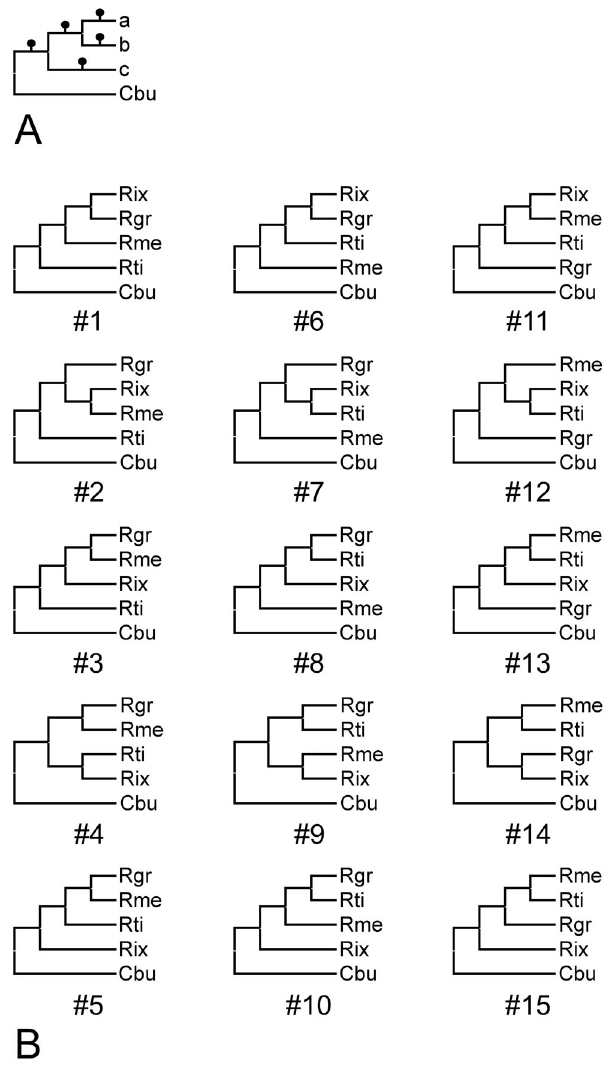
Figure 4. Generation of candidate tree topologies for likeli- hood-based significance testing based on MLST markers. 15 candidate topologies were generated from a four organism basic tree ( A ) comprising Coxiella burnetii (acronym ‘‘Cbu’’) as outgroup together with three Rickettsiella strains in positions a–c. The candidate topologies tested ( B ) were generated from this basic tree by the following steps: 1. Permutative addition of three Rickettsiella strains representing the species Rickettsiella grylli (‘‘Rgr’’) and the pathotypes ‘ Rickettsiella melolonthae ’ (‘‘Rme’’) and ‘ Rickettsiella tipulae ’ (‘‘Rti’’) to positions a–c generates a maximum of six tree topologies that are pair-wise identical, i.e. a total of three different topologies. 2. Subsequent addition of the pathotype ‘ Rickettsiella ixodidis ’ (‘‘Rix’’) to any of the five branches indicated by a black dot in any of the previously generated trees.